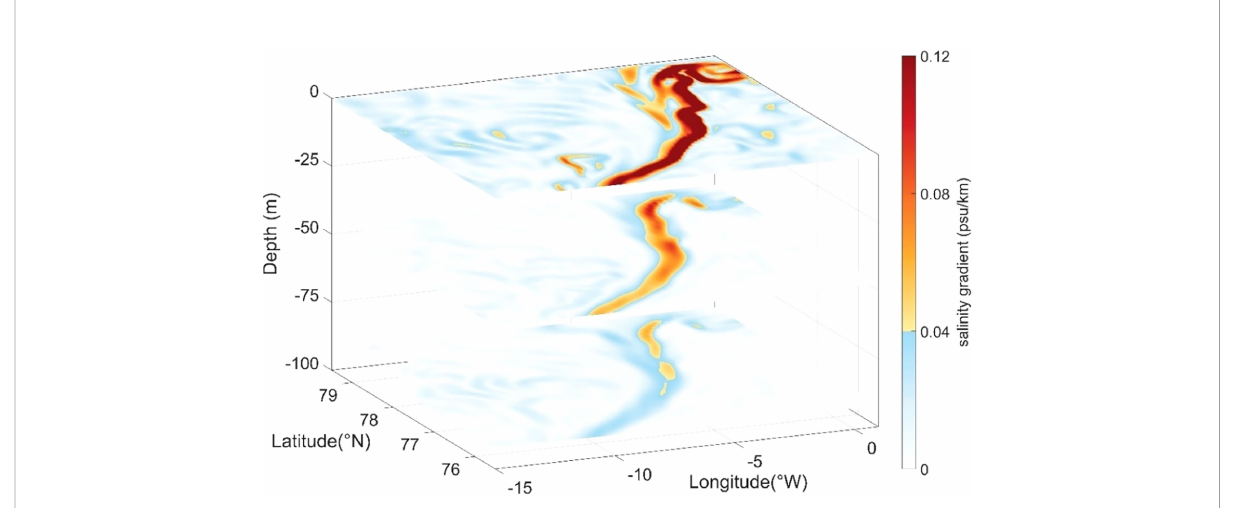
FIGURE 8 The spatial distributions of the horizontal gradient of the salinity in 0, 47, and 92 m on 6 August